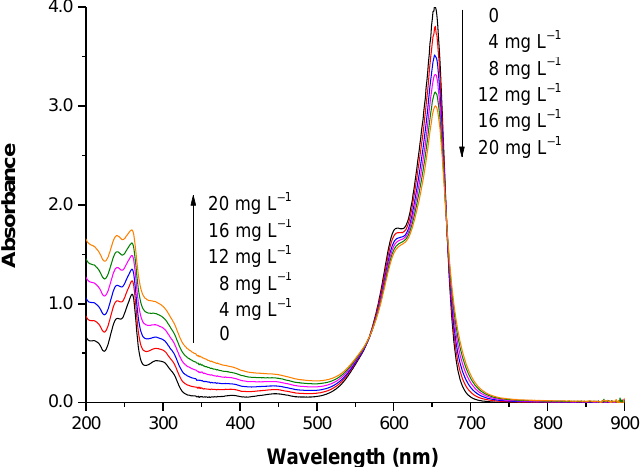
Figure 5. UV–vis spectra of BB 3 (2.5 × 10 − 2 g L − 1 ) in aqueous solutions with varying concentrations of potassium humate.